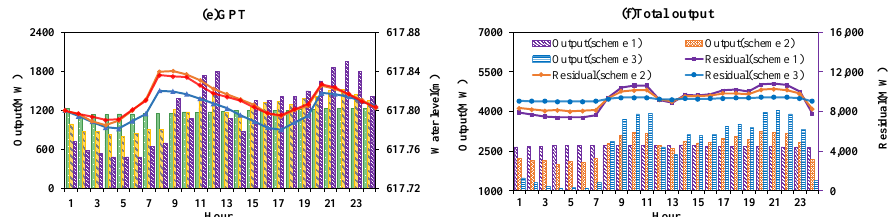
Figure 12. Detailed scheduling results of three typical schemes obtained by EGSA in Spring.